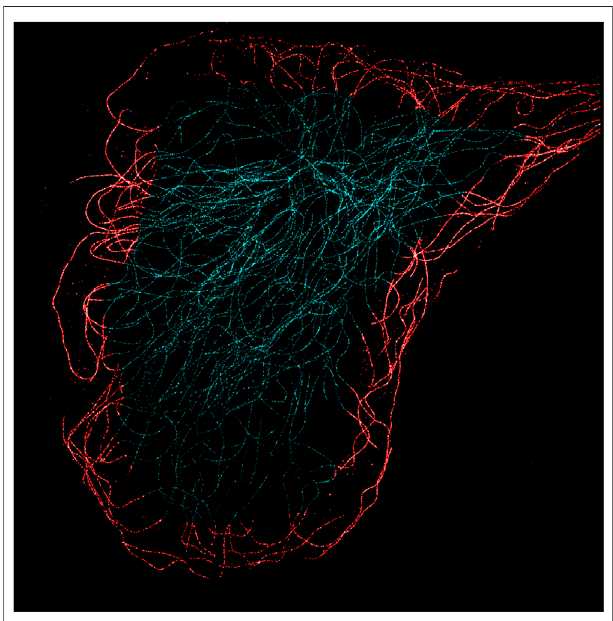
FIGURE 3 | MT STORM image of a control cell (Hs 578Bst cell line). The 4 μ m annular band marked in red is the region selected to evaluate the MT occupancy and curvature.